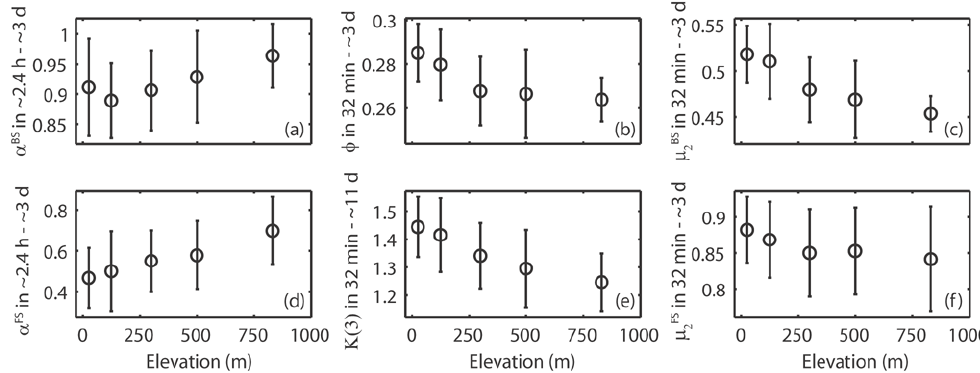
Fig. 8. Relation between the metrics in the range of frontal systems and the elevation; see main text for details.